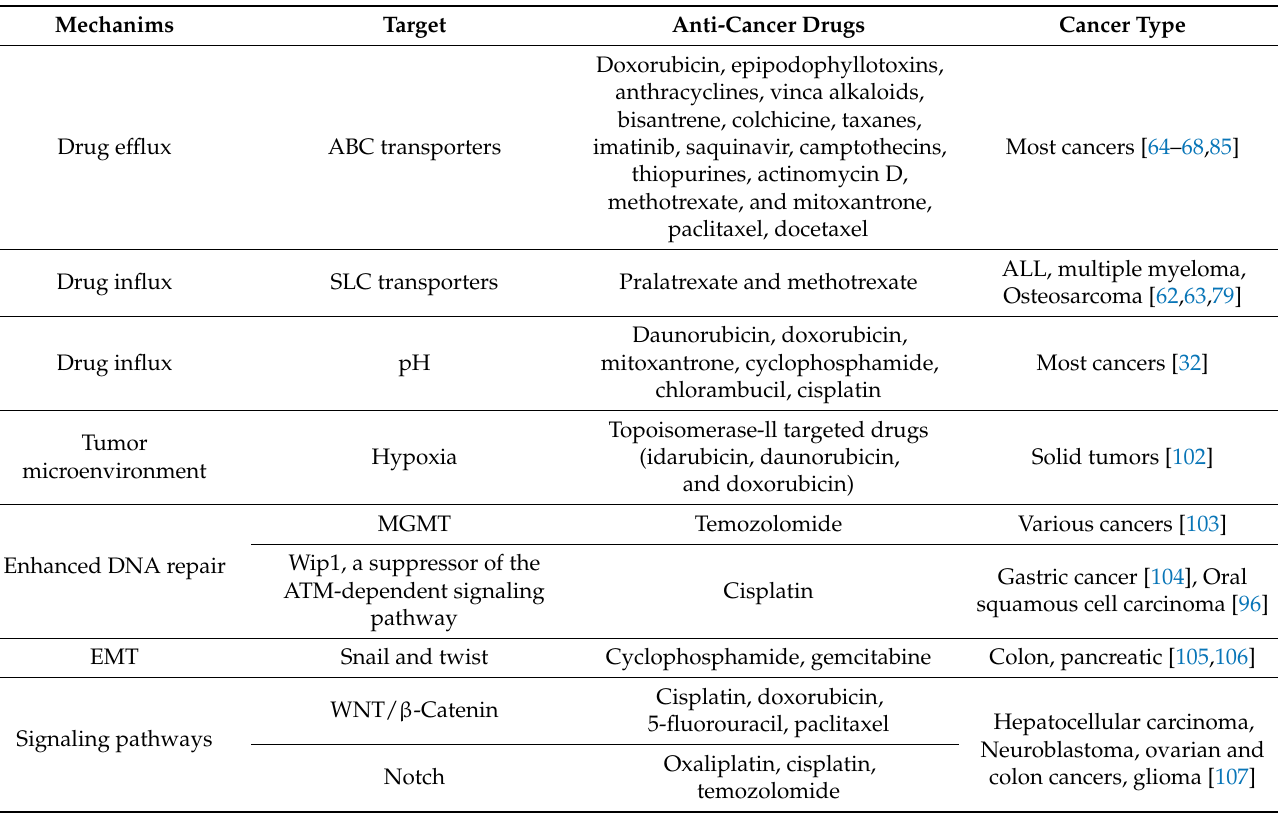
Table 2. The underlying mechanisms causing chemoresistance in